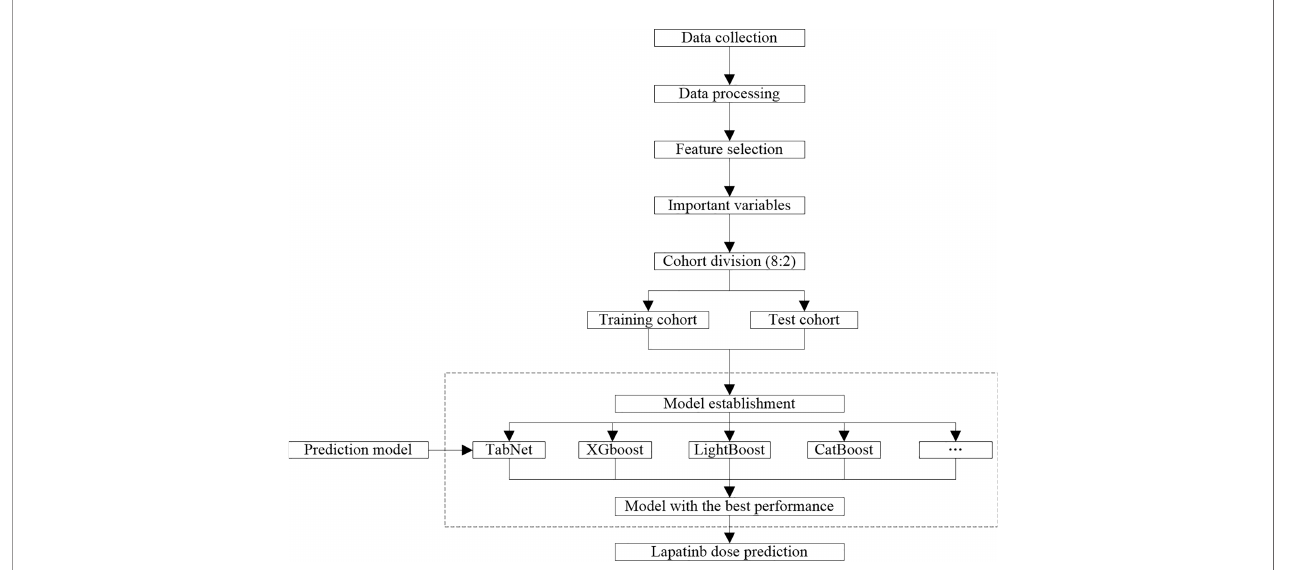
FIGURE 1 | Work fl ow of data process and model